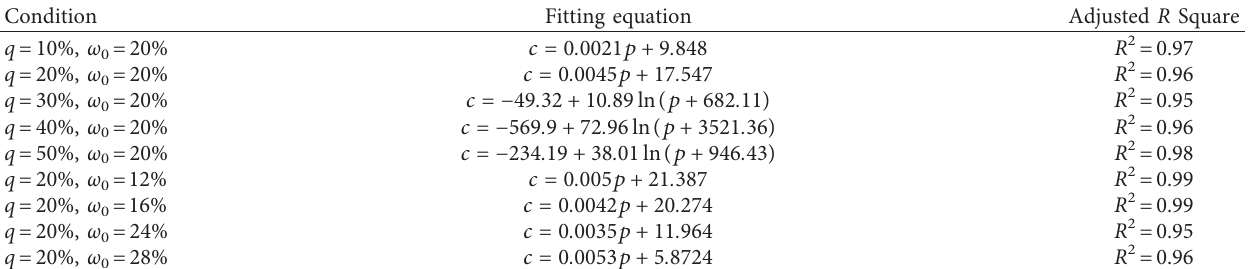
Table 4: Fitting results of c - p relation.